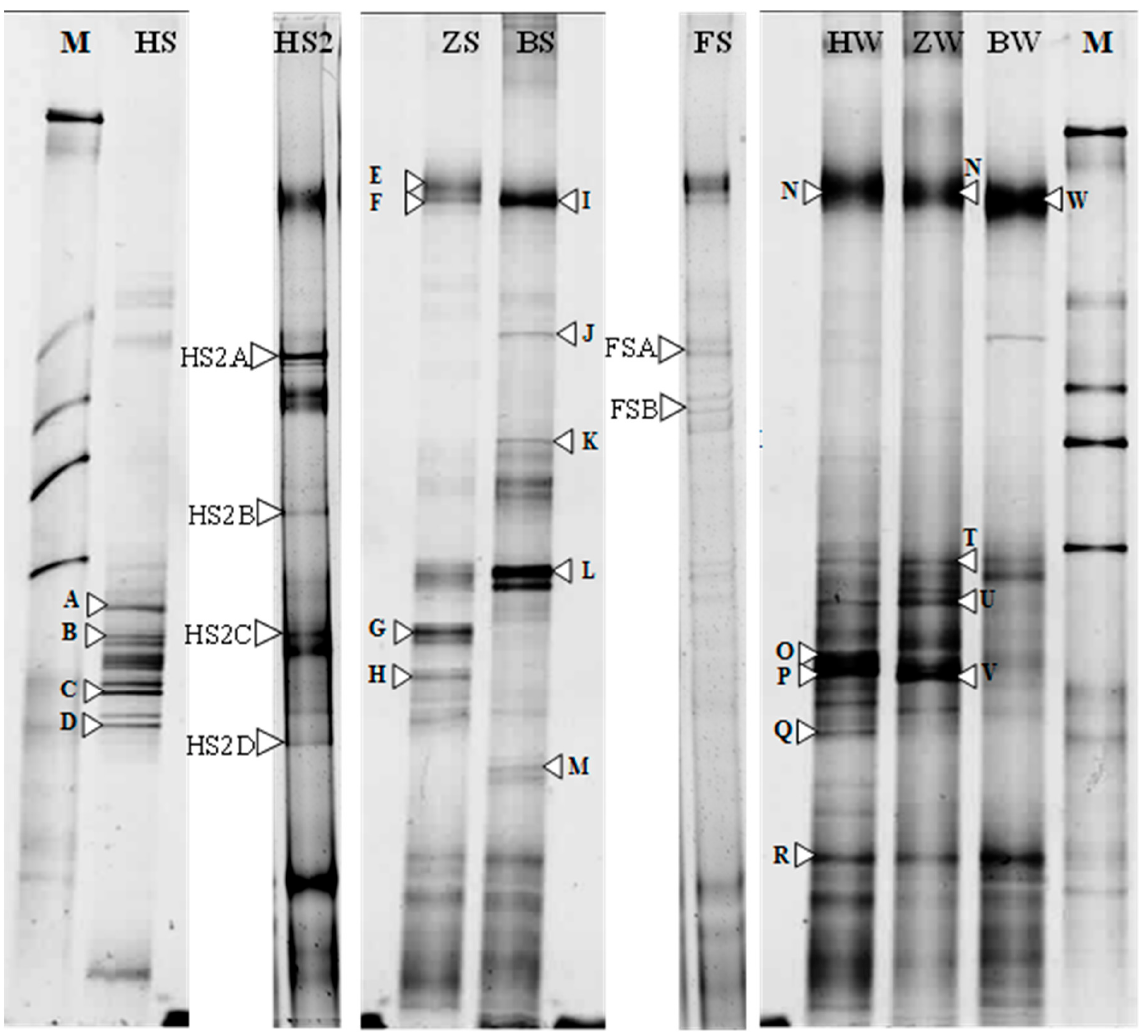
Figure 3. Archaeal 16S rRNA gene targeted PCR-DGGE analysis of sediment/salt crystal and water samples from soda lakes of Wadi El-Natrun. Lane M: molecular weight marker (Kbp); Lane HS: sediment sample of Hamra Lake; Lane HS2: salt crystals of Hamra Lake; Lane ZS: salt crystals of Zugm Lake; Lane BS: salt crystals of El-Beida Lake; Lane FS: sediment of Fazda Lake; Lane HW: water sample of Hamra Lake; Lane ZW: water of Zugm Lake; and Lane BW: water of El-Beida Lake. Table 3. Diversity and richness indices for archaeal clone libraries.